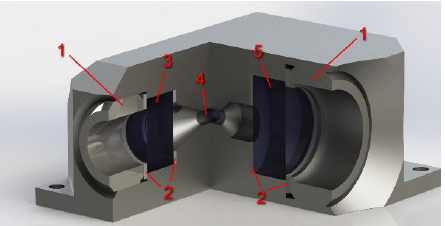
Figure 2. The scheme of the high-pressure gas cell: 1—nut rings, 2—polytetrafluoroethylene (PTFE) gaskets, 3—input window for passing the excitation light, 4—useful volume for the studied gas, 5—output window for collection of the scattered light.